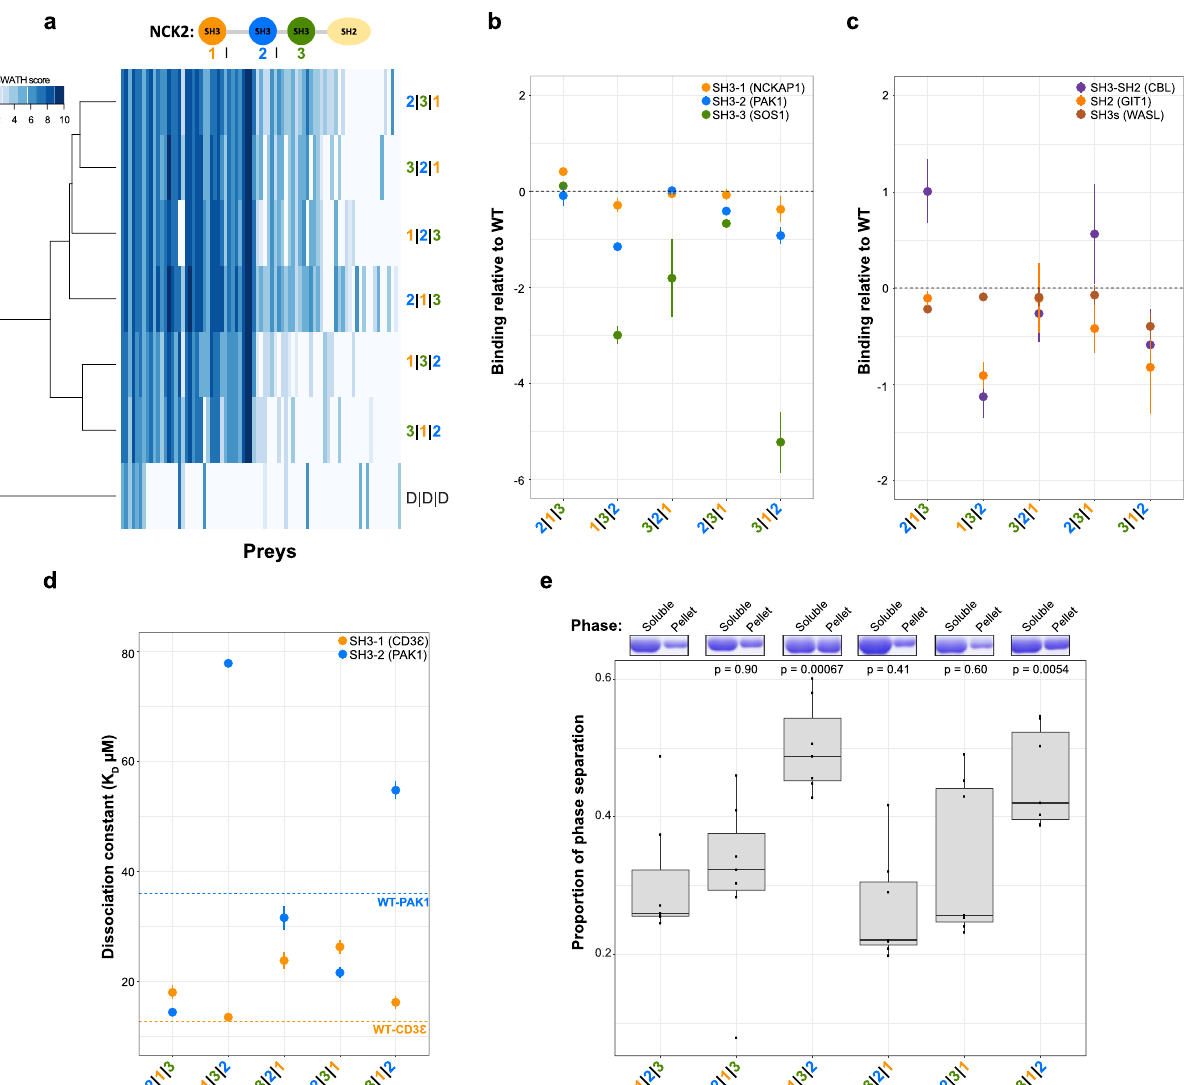
Fig. 5 Human NCK2 SH3 domain shuf fl ing alters its interactome in cells and its ability to phase separate. a – c AP-SWATH quantitative MS data of NCK2 PPIs (duplicates, PPIs with a SAINT analysis FDR < 1%, see “ Methods ” ). a Scaled cartoon representation of NCK2 with its domains. Log2 of the average spectral counts (SWATH score) for the PPIs are shown. Baits were clustered based on the similarity of their PPI pro fi les. The color code represents the PPI strength (SWATH score). The bait nomenclature 1|2|3 is for WT NCK2 and D|D|D is for the triple SH3-inactive negative control (W38K/W148K/ W234K). b , c NCK2 PPIs for partners with known binding sites on NCK2. The spectral count from the two biological replicates was compared to the WT NCK2 score (Ratio NCK2mut/NCK2WT). The log2 average ratio is shown (WT NCK2 ratio = 0). Error bar represents the mean plus and minus one standard deviation ( n = 2 independent biological experiments). d Fluorescence polarization dissociation constants ( K D ) for NCK2 full-length recombinant proteins with an SH3-1 direct (CD3 Ɛ ) or SH3-2 direct (PAK1) partner (triplicates, K D error values represent plus and minus one SE). e NCK2 phase separation after 24 h of incubation. Soluble and phase-separated (pellet) proteins were quanti fi ed via Coomassie staining (typical replicate shown above). The proportion of proteins in the pellet compared to the total protein content (soluble + pellet) is shown for the seven replicates. Proportions of phase- separated proteins were compared to WT NCK2 (pairwise one-way ANOVA, p values: 2|1|3 = 0.90, 1|3|2 = 0.00067, 3|2|1 = 0.41, 2|3|1 = 0.60 and 3|1|2 = 0.0054). For the boxplot, the median is represented as a bold center line and hinges are for the 25th and 75th percentiles ( fi rst and third quartiles). Whiskers extend from the hinges to a maximum of 1.5 times the Q3 – Q1 interquartile range. The black dots represent the different data points. Source data are provided as a Source Data fi le. See also Supplementary Data